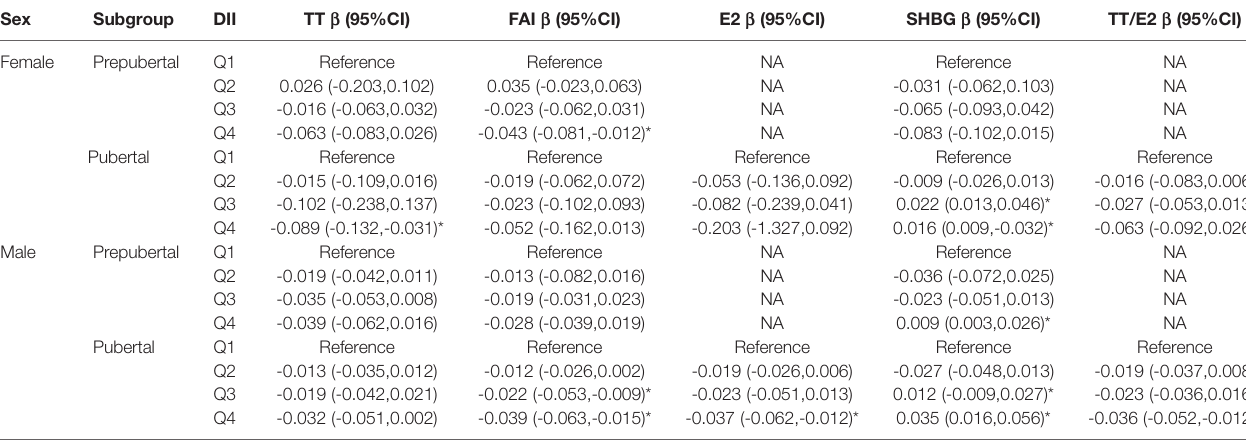
TABLE 4 | Association between categorical dietary in fl ammatory index (DII) and sex hormones by sex-puberty status groups in 6-19-year old participants in NHANES 2015-2016. Sex